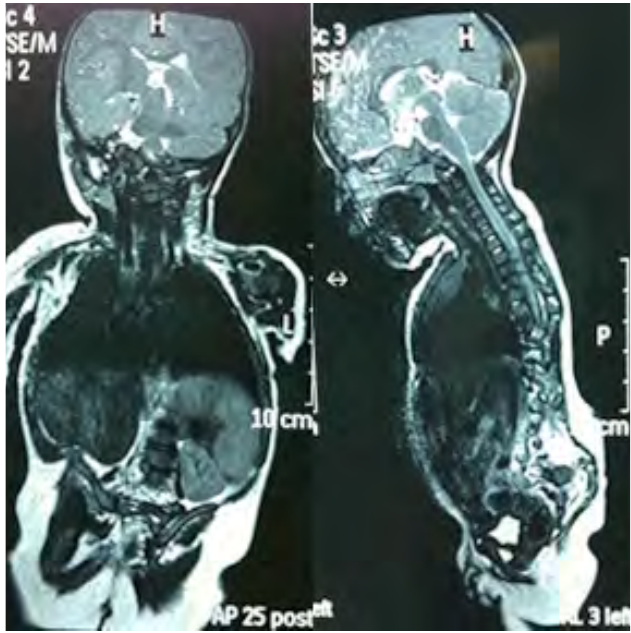
Figure 3 : MRI image showing renal ectopia.